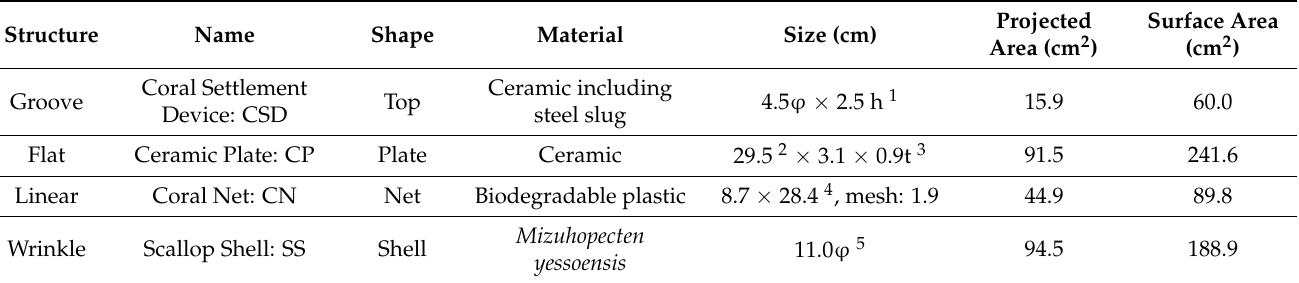
Table 1. Specifications of the substrata.